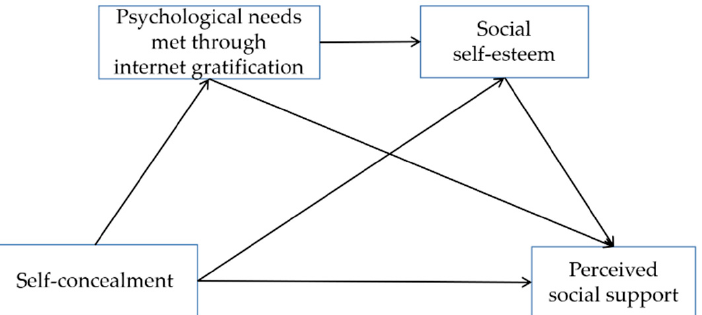
Figure 1. The hypothesized serial mediation model with ‘psychological needs met through internet gratification’ and ‘social self-esteem’ as mediators of the linkage between ‘self-concealment’ and ‘perceived social support’.